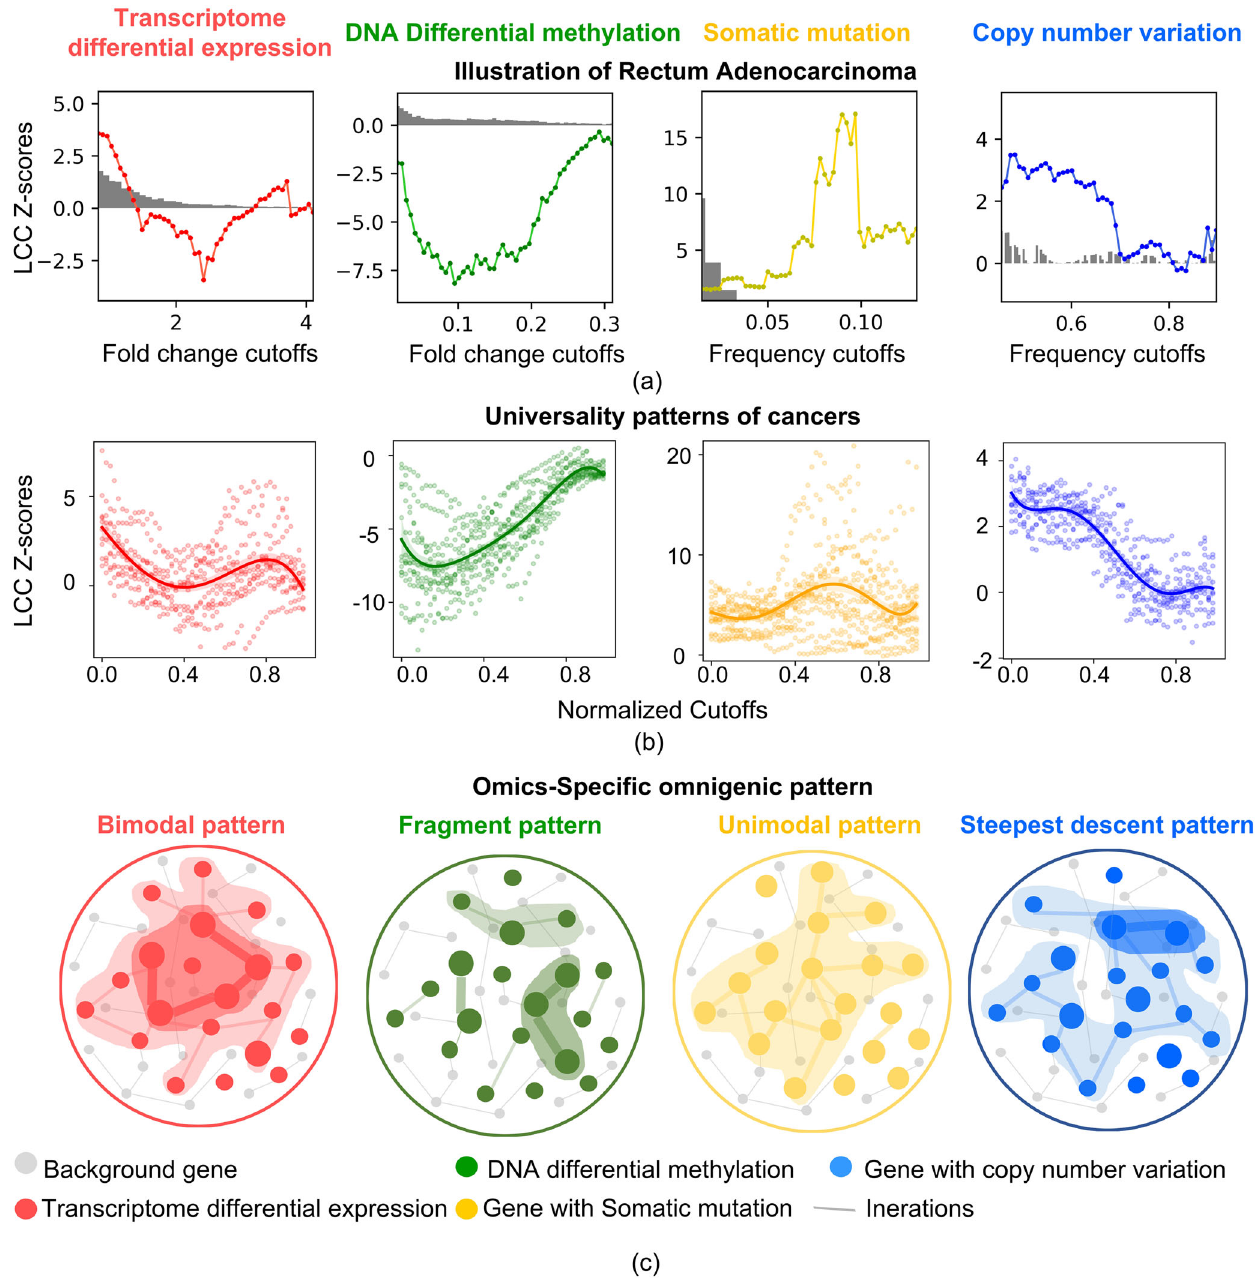
Fig. 1 Omics-speci fi c omnigenic pattern of cancer. a Network-based Connectivity Line, CLine . Illustration of Rectum Adenocarcinoma (READ). The perturbed genes in the transcriptome, methylation, somatic mutation and CNV aspects present an omics-speci fi c omnigenic pattern. The abscissa is the cutoffs of fold change and frequency index, and the ordinate calculates the connectivity signi fi cance LCC z-score. i. The CLine of the transcriptome aspect forms a bimodal pattern. In the low perturbation cutoff part ( f i = 0.8), the LCC z-score of 3674 genes forms the fi rst local peak in the line (z-score = 3.58). In the high perturbation cutoff part ( f i = 3.7), the LCC z-score of 147 genes forms the second local peak (z-score = 1.28). ii. The CLine of the methylation aspect presents a fragmented pattern, and all LCC z-scores are below 0 regardless of the low or high perturbation cutoffs. iii. The CLine of the somatic mutation aspect presents a unimodal pattern. When f i = 0.09, the LCC z-score = 17.03, which forms the only peak in the line. iv. The CLine of CNV aspect presents a steepest descent pattern. When the cutoffs slightly increase from 0.68 to 0.70, LCC z-scores drop from 1.92 (signi fi cant connectivity) to 0.3 (quasi-random) in the high perturbation cutoff part. The grey histograms represent the distribution of the number of genes under different cutoffs. b Universality of pattern. Least squares fi tting was used to construct a uniform curve across cancers ( UCurve ), highlighted by heavy continuous lines in the normalised coordinates. The red UCurve fi ts bimodal CLine in 66.7% of cancers; the green UCurve fi ts the fragment CLine in 86.7% of cancers; the yellow UCurve fi ts the unimodal CLine in 93.3% of cancers; and the blue UCurve fi ts the steepest descent CLine in 93.3% of cancers (details in Supplementary Figs. 1 – 4). c Different omics aspects of cancer show perturbations of the biological network in different ways, forming four omics-speci fi c neighbourhoods, each of which exhibits different connectivity characteristics. Both the node sizes and thickness of edges are proportional to the strength of the perturbation. We highlighted the weakly-perturbed peripheral region with light shades, and the highly-perturbed core region with dark shades.